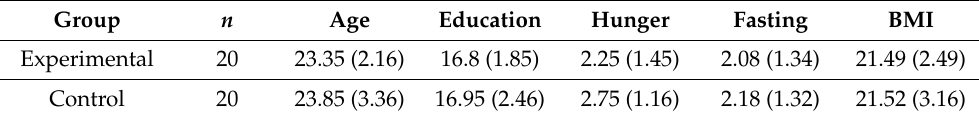
Table 1. Participants’ demographic